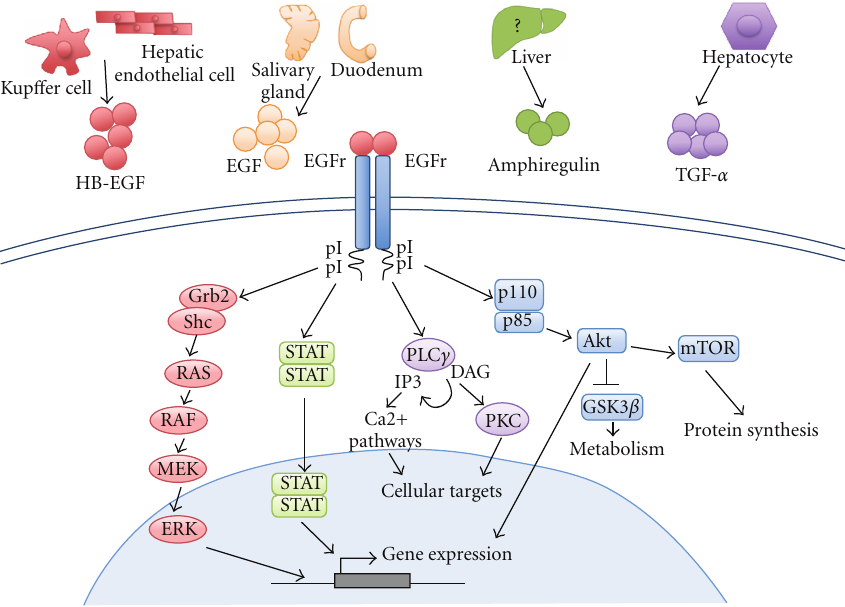
Figure 1: EGFR induced signaling pathways. The major source of each EGFR ligands involved in liver regeneration is schematized. Amphiregulin liver induction right after PH is not su ffi cient to determine the cellular origin of this secretion. Upon binding of its ligands, EGFR homodimerizes leading to phosphorylation of many tyrosine residues localized in the carboxy-terminal tail of EGFR. Phospho-EGFR is then able to recruit adaptor proteins. They transduce the EGFR signaling by inducing several EGFR-dependent pathways, including the RAS-MAPkinase, PI3K-AKT, PLC γ , and Stat pathways. Collectively these pathways control proliferation, di ff erentiation, migration, and survival of the